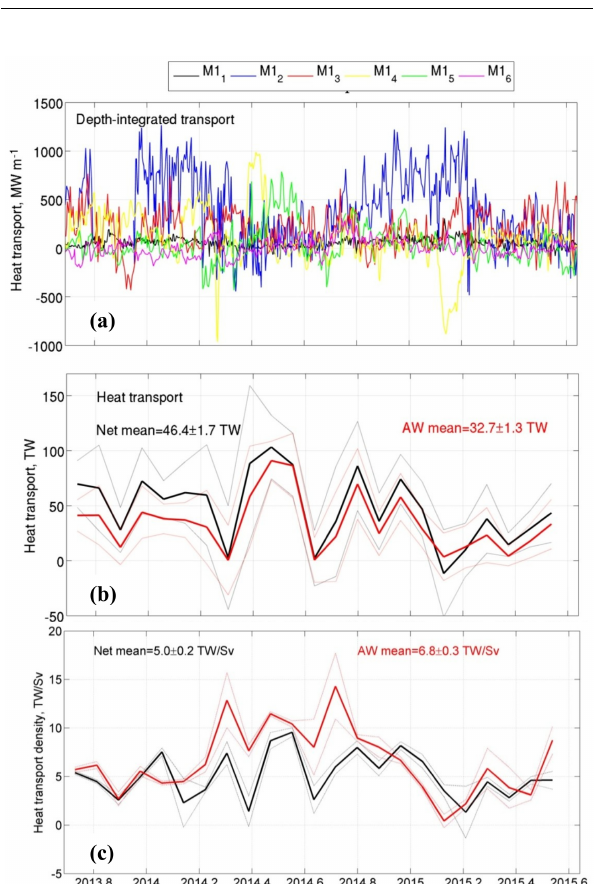
Figure 9. (a) Depth-integrated heat transports in the layer spanned by 2013–2015 CTD and velocity observations at six moorings at the Laptev Sea slope; (b) monthly net heat transport in the upper 780m layer (black) and in the AW layer (red) across the 125 ◦ E section. (c) Monthly density of heat transport across the Laptev Sea slope in the upper 780m layer (black curve) and in the AW layer (red curve). Dotted lines show 1 standard deviation intervals.